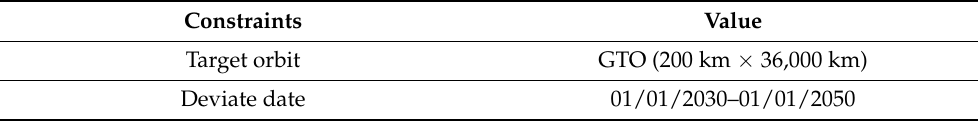
Table 1. Constraints of the direct capture